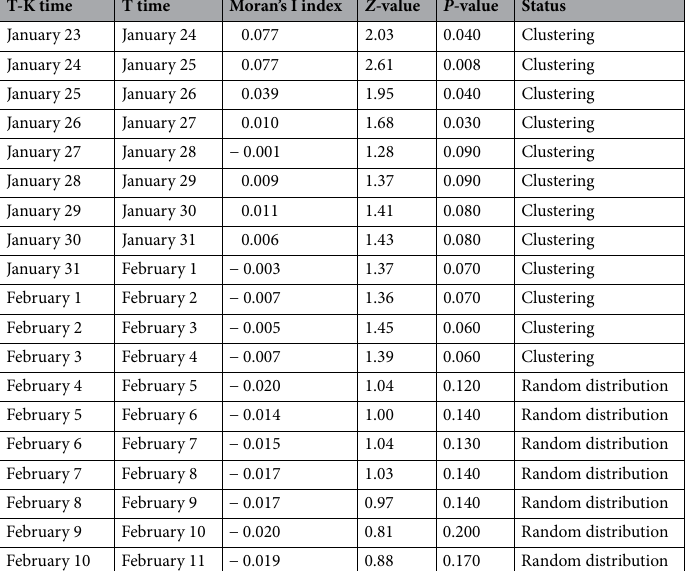
Table 1. Results of spatio-temporal autocorrelation analysis of the new diagnosed cases of COVID-19 in Mainland China.